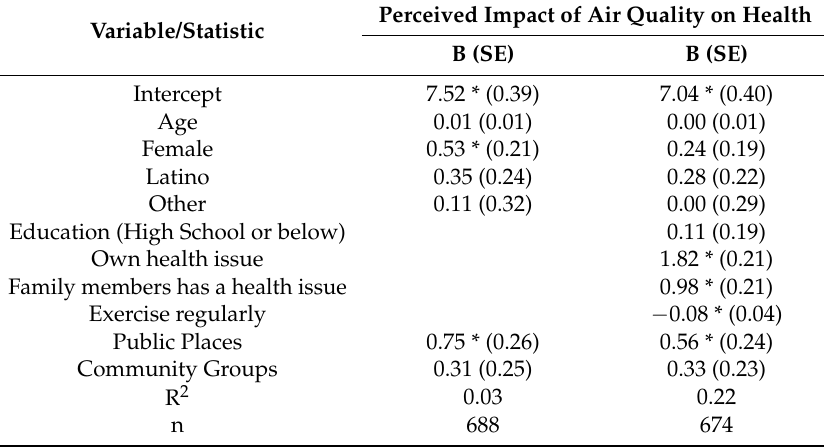
Table 4. Perceived impact of air quality on own